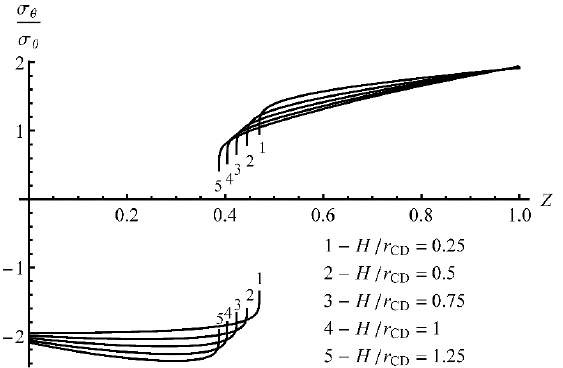
Figure 3. Through ‐ thickness distribution of the circumferential stress at γ = 0.1 and several process stages.